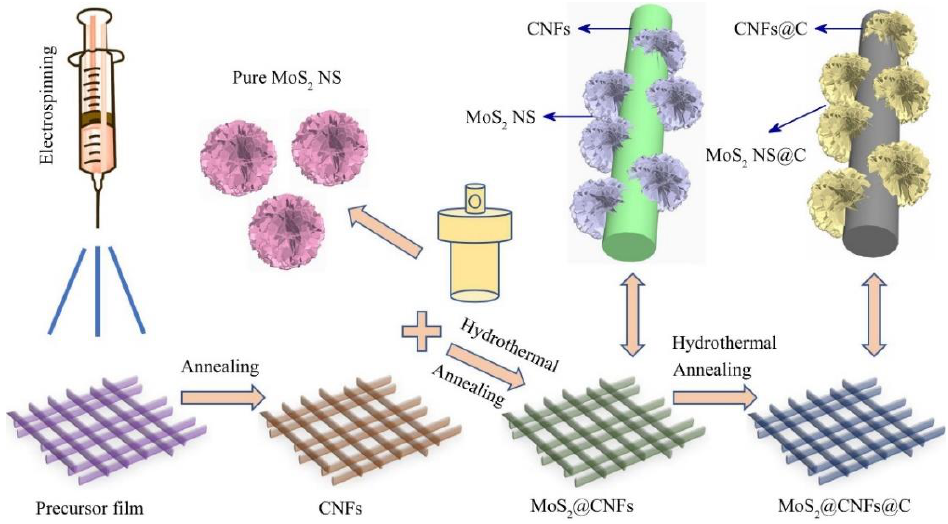
Figure 1. Schematic illustration of the fabrication of MoS 2 @CNFs@C film electrode.